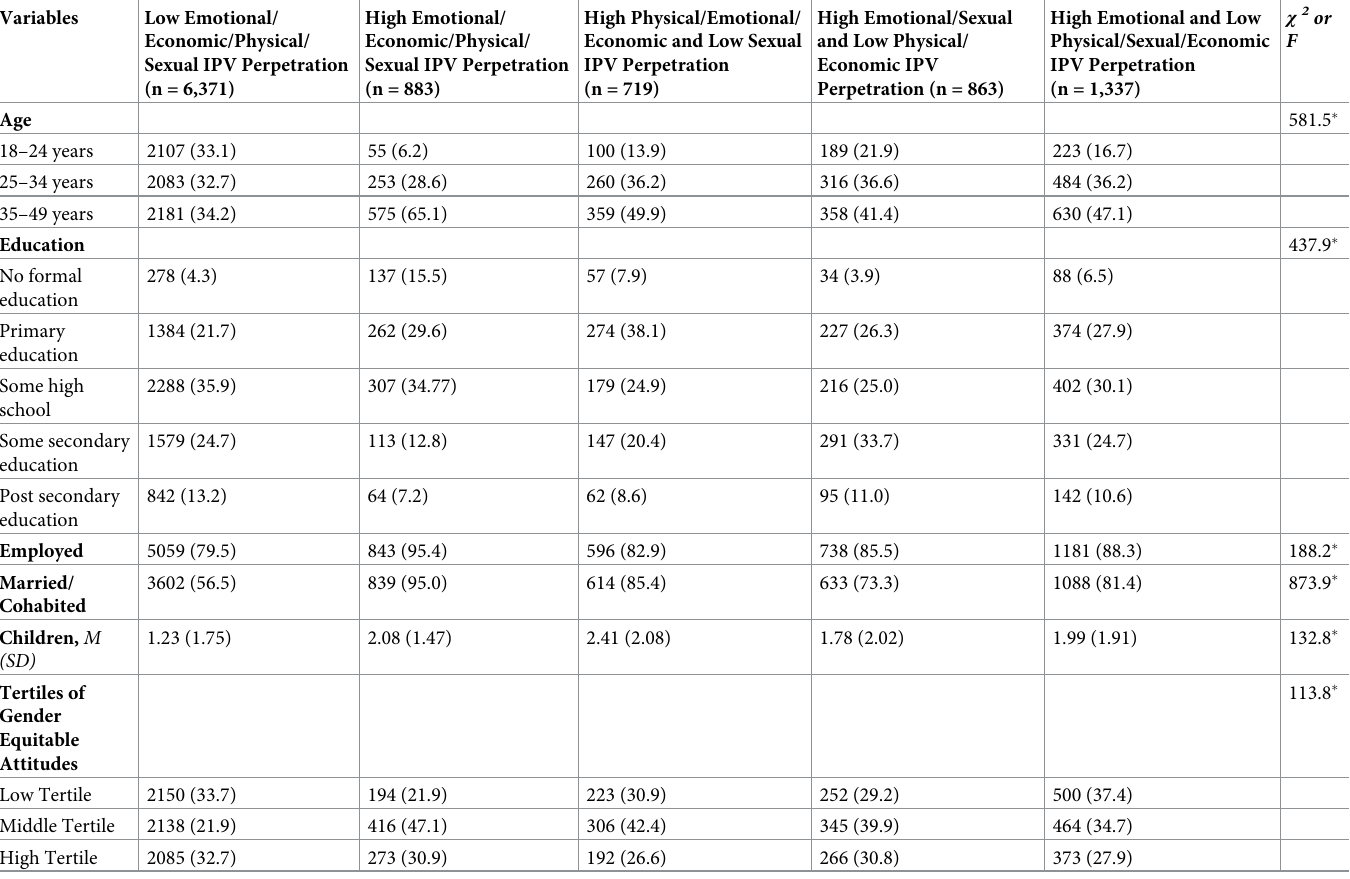
Table 3. Prevalence of demographics and gender equitable attitudes by latent class membership among male participants recruited for UN Multi-Country Study on Men and Violence.